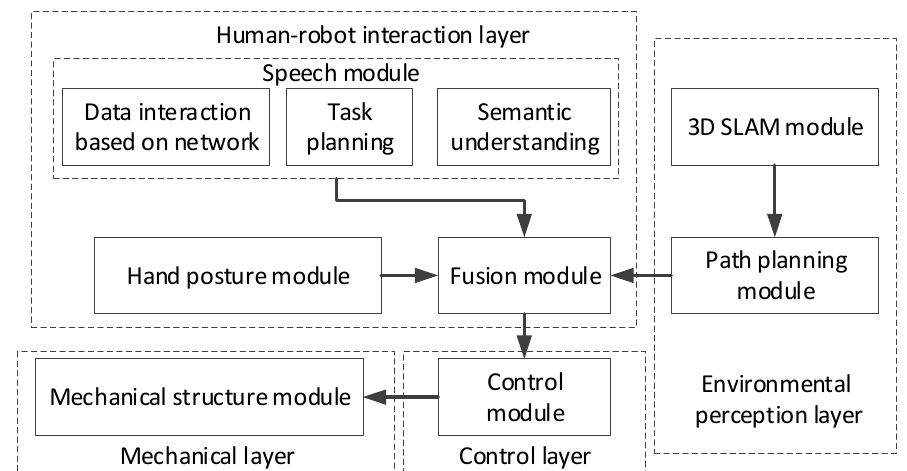
Figure 2. Framework of the proposed system.